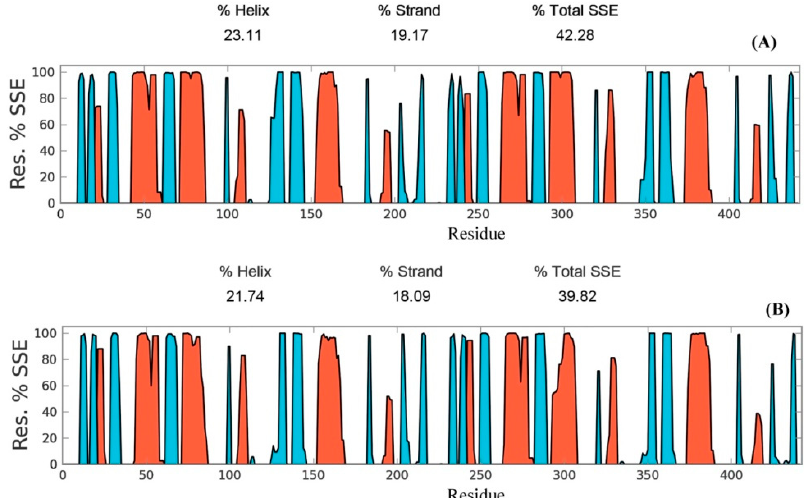
Figure 4. Secondary structure elements evolution of reduced ( A ) and hyperoxidized ( B ) Prdx6 during the simulation period. Helices are shown in red and strands are shown in cyan.